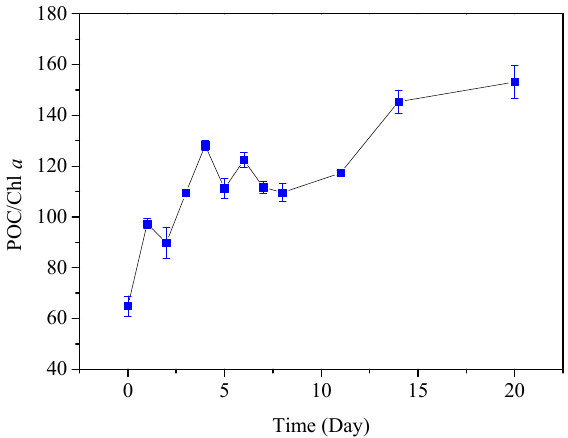
Figure 7. Time-series of POC: Chl a during cyanobacteria degradation to characterize the proportion of fresh cyanobacteria and cyanobacteria degradation residues in PPOM.